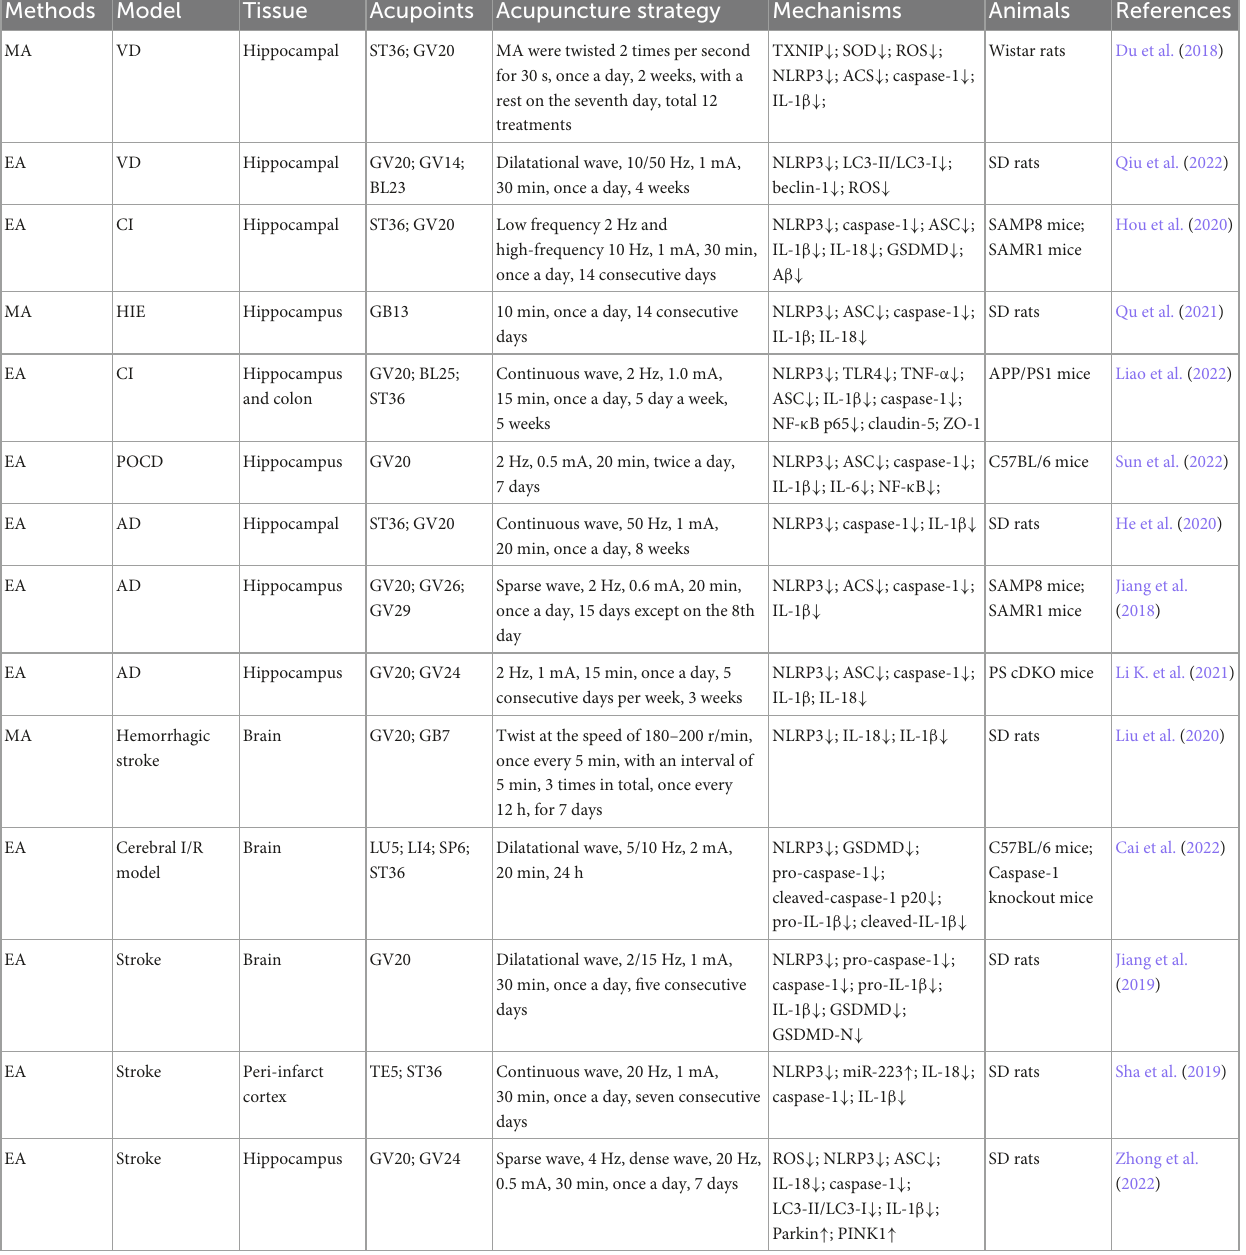
TABLE 1 Acupuncture methods for VD, AD, and stroke via NLRP3 inflammasome. Methods